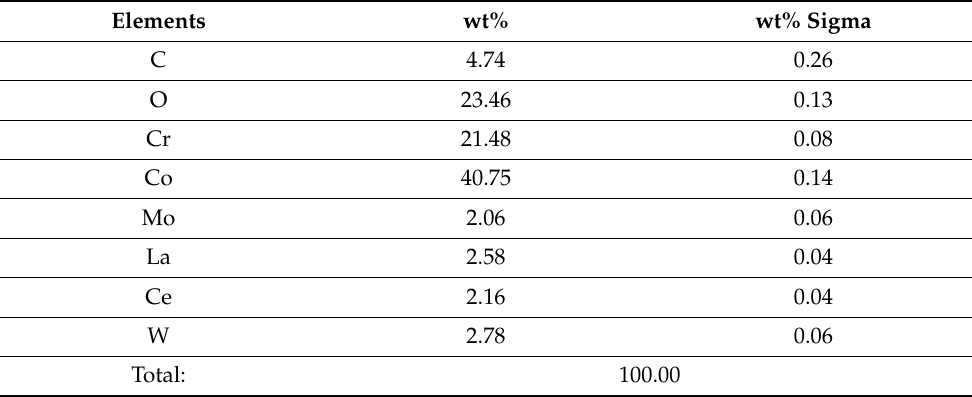
Table 5. Quantitatively determined values of the content of the elements on the surface of sample